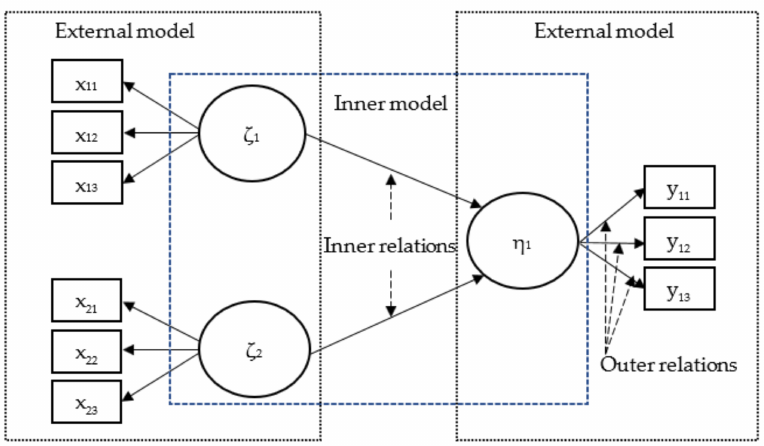
Figure 1. Example of the SEM